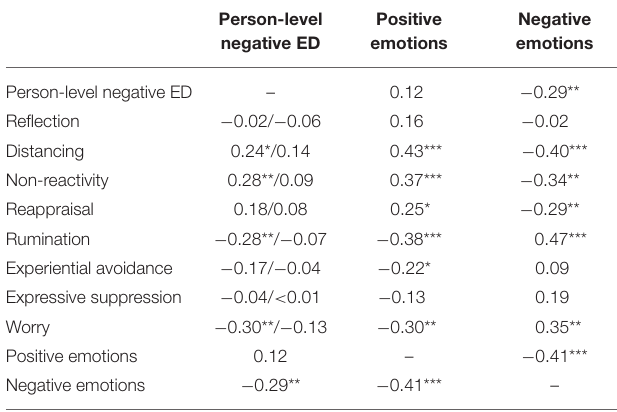
TABLE 1 | Correlation coefficients between the two ER items and associations between baseline and daily measures of ER. Within-person correlation